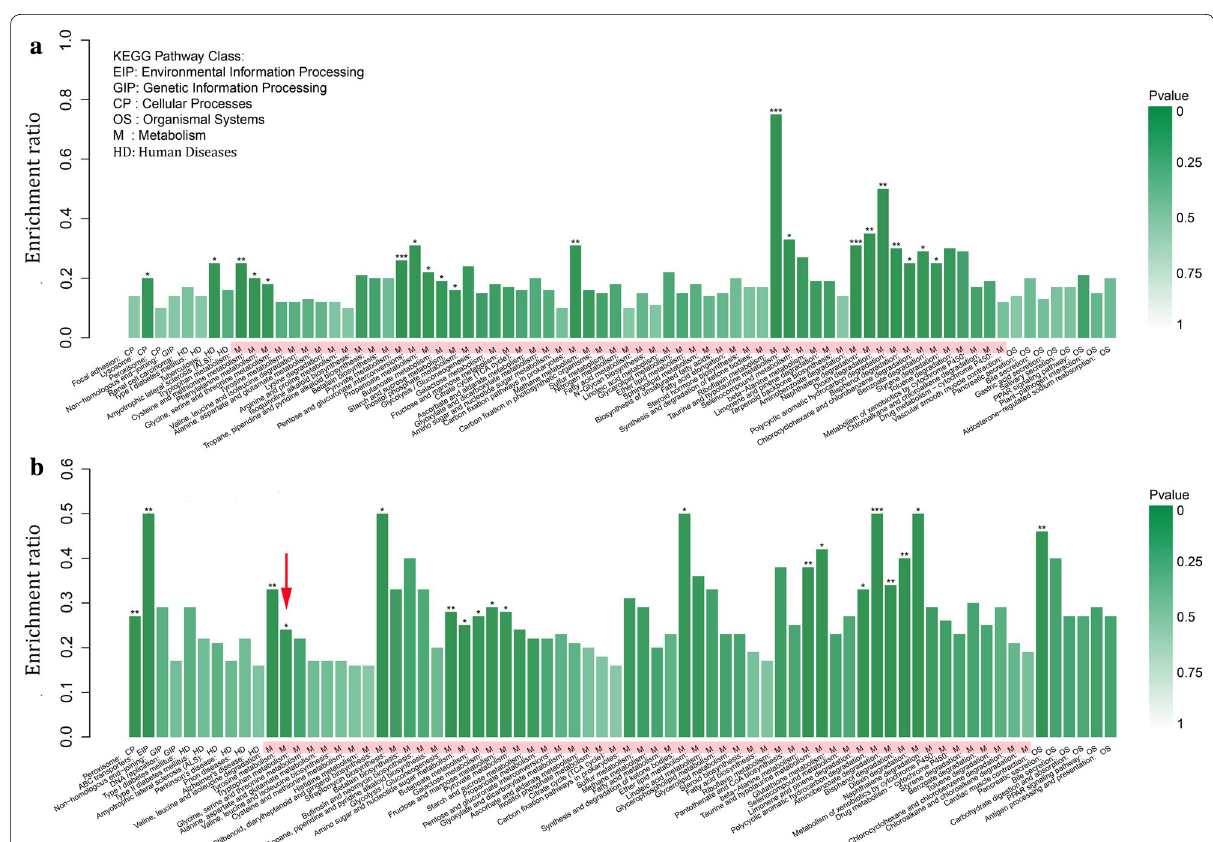
Fig. 5 KEGG pathway enrichment analysis of DEGs. a DEGs in T1 vs Ck1, and b DEGs in T2 vs